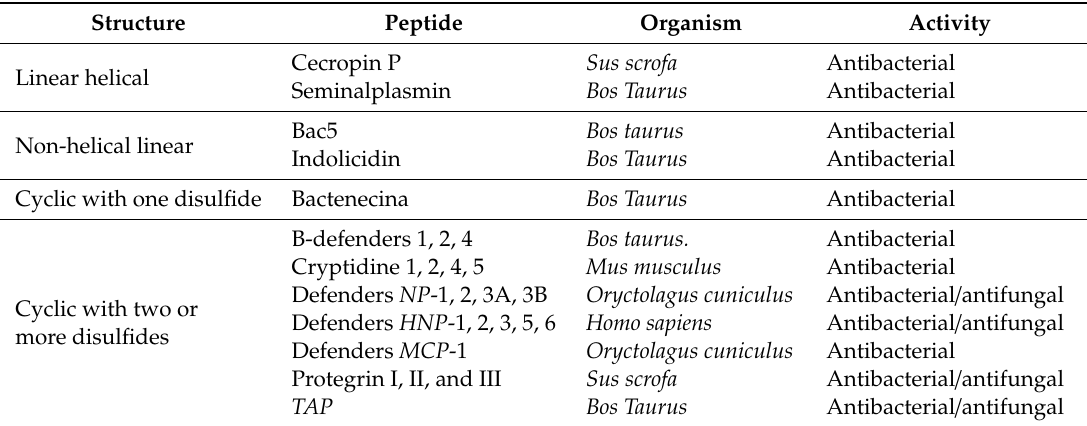
Table 6. Classification of the antimicrobial peptides of mammals